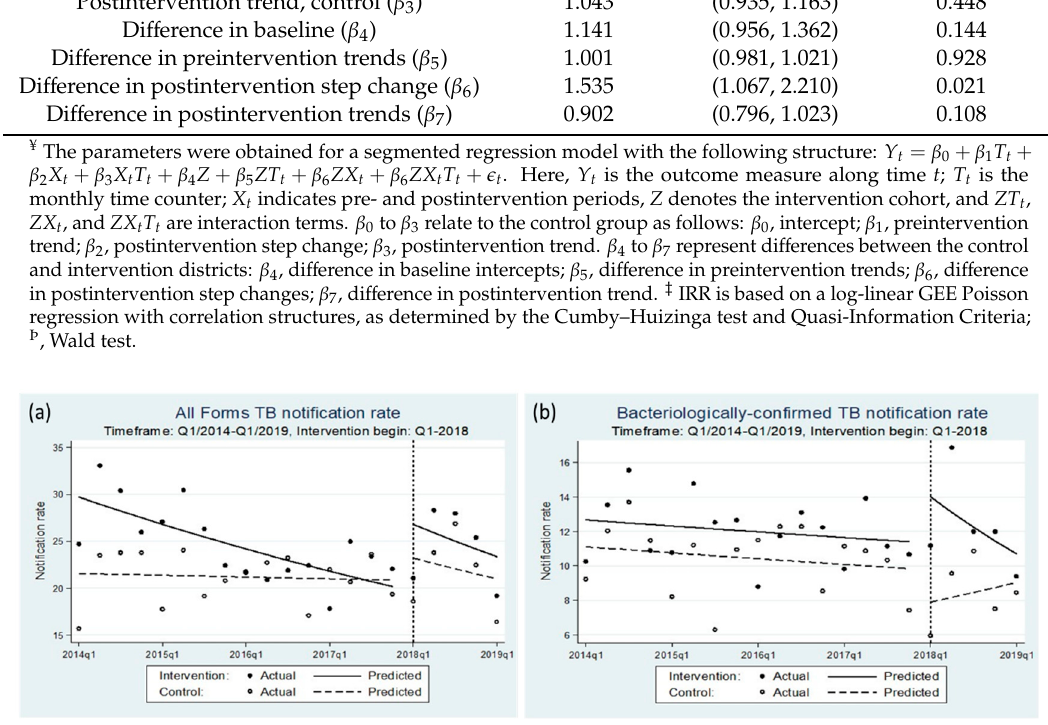
Figure 5. Comparative ITS analysis model graphs of population-standardized quarterly